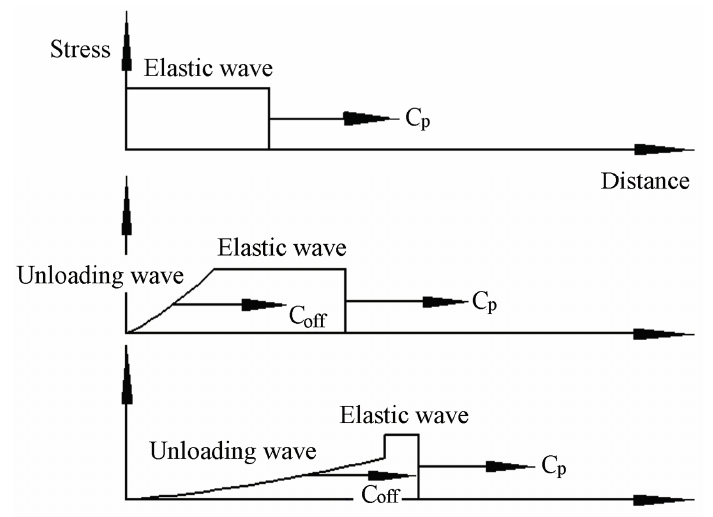
Figure 5. Top view of micro-gears punched by different thickness of silica gel: ( a ) 100 µm; ( b ) 200 µm; and ( c ) 300 µm.